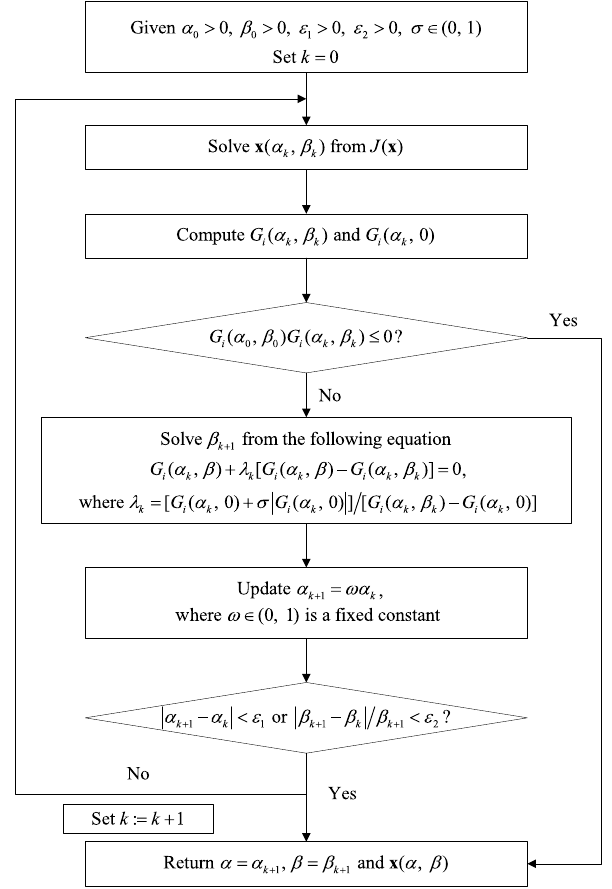
Figure 2. The flow chart of determining the regularization parame- ters by using the linear model function